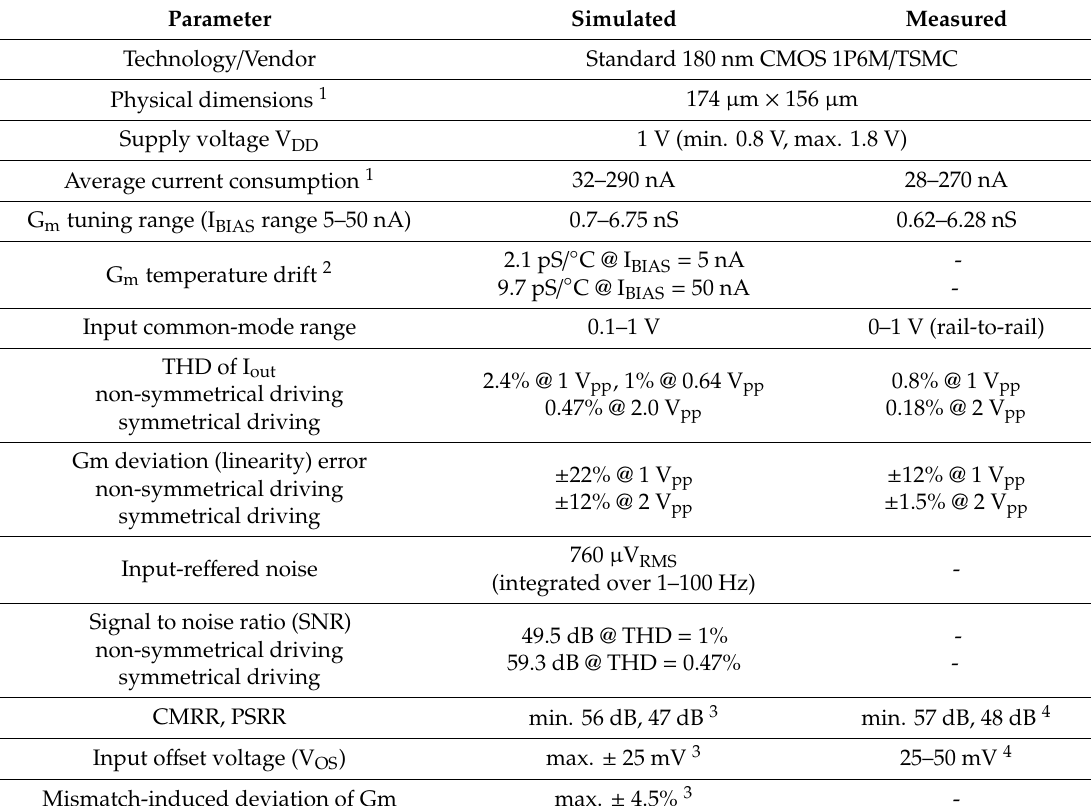
Table 1. Parameters of the prototype LTA at V DD = 1 V and 27 ◦